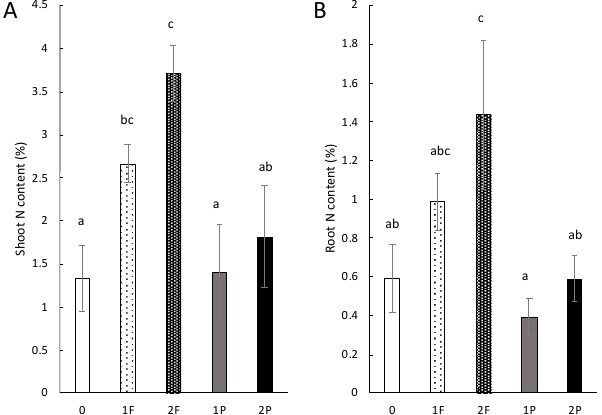
Figure 6. Amendment effects on tissue N content. ( A ) Shoot and ( B ) root N content (% of dry mass). Unamended (0), one fertilizer application (1F), two fertilizer applications (2F), one procyanidin application (1P), and two procyanidin applications (2P). n = 3 for each treatment. Vertical bars indicate standard errors. Differences in letters (a, c, ab, bc, and abc) indicate a difference in treatment (Nemenyi’s test; α < 0.05).